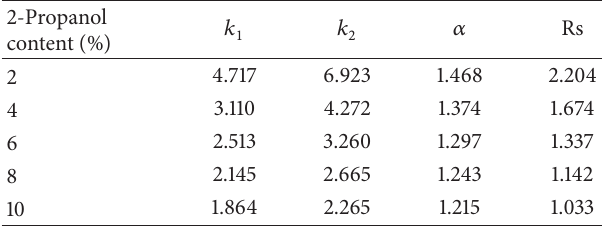
Table 1: Effect of 2-propanol content on the stereoselective separa- tion of TFLV a .